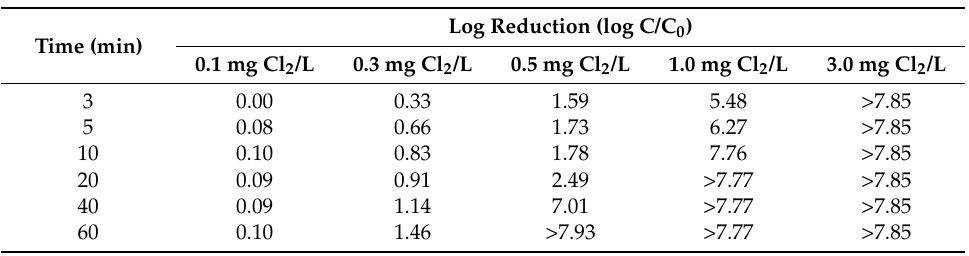
Figure 1. Changes of enterococci concentration (suspension of VRE). Table 1. Log reduction value for each initial chlorine concentration and stirring time (suspension of vancomycin-resistant enterococci in PBS solution).